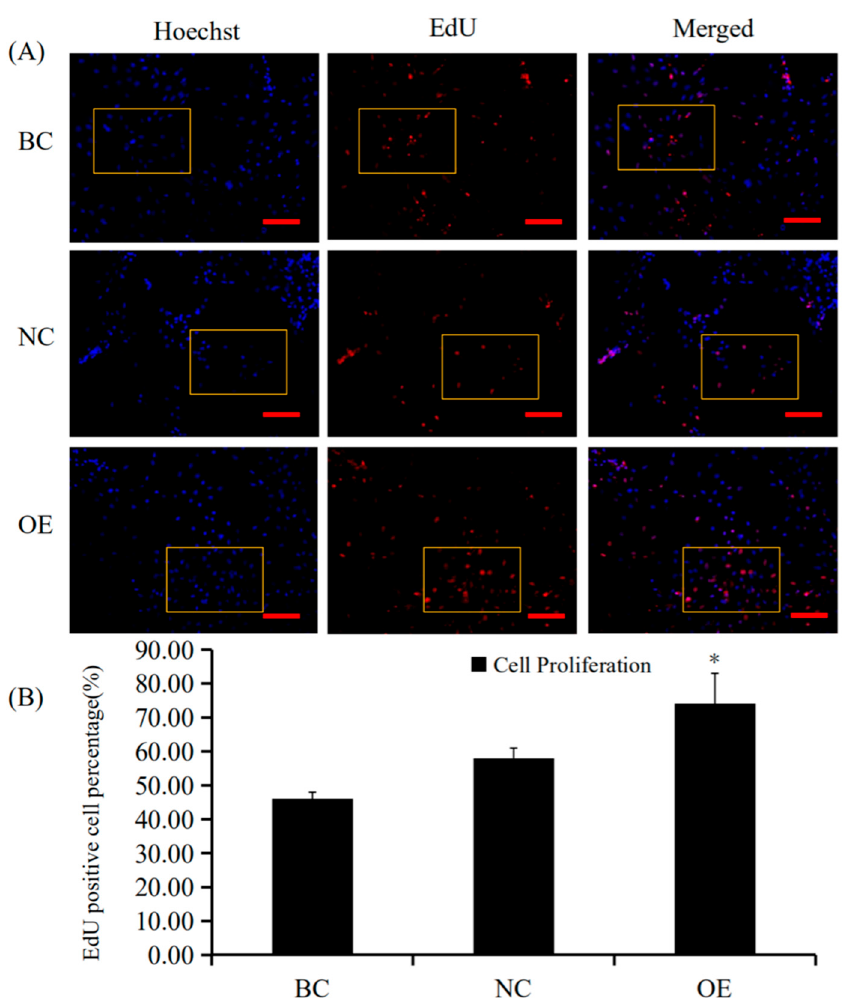
Figure 6. E ff ects of overexpressing RAC1 on granulosa cell proliferation. The e ff ects EdU cell proliferation assay was used to assess the e ff ects of overexpressing RAC1 on GC proliferation. ( A ) The GCs were transfected with di ff erent treatment groups. OE group: pYr-adshuttle-4- RAC1 vector; NC group: pYr-adshuttle-4 empty vector; BC group: absence of expression vector. Blue fluorescence was seen in all cell nuclei since Hoechst33342 staining, cells labeled with red fluorescence suggesting their newly produced DNA (original magnification × 20) (Figure S2, original magnification × 40). ( B ) The percentage of GC proliferation after cells were transfected with pYr-adshuttle-4- RAC1 vector. Data represent means ± SEM ( n = 10). Bars with superscripts suggest the statistically noteworthy di ff erence in comparison to the control groups (* p < 0.05).